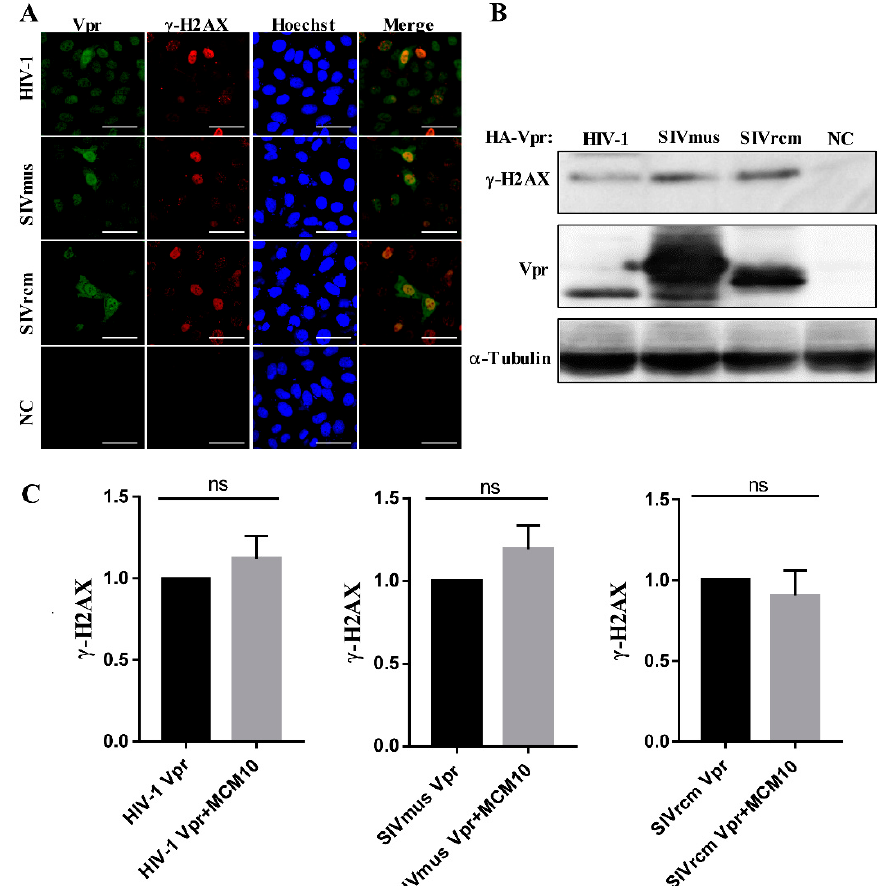
Figure 7. MCM10 did not alleviate DNA damage response (DDR) induced by HIV-1, SIVmus,